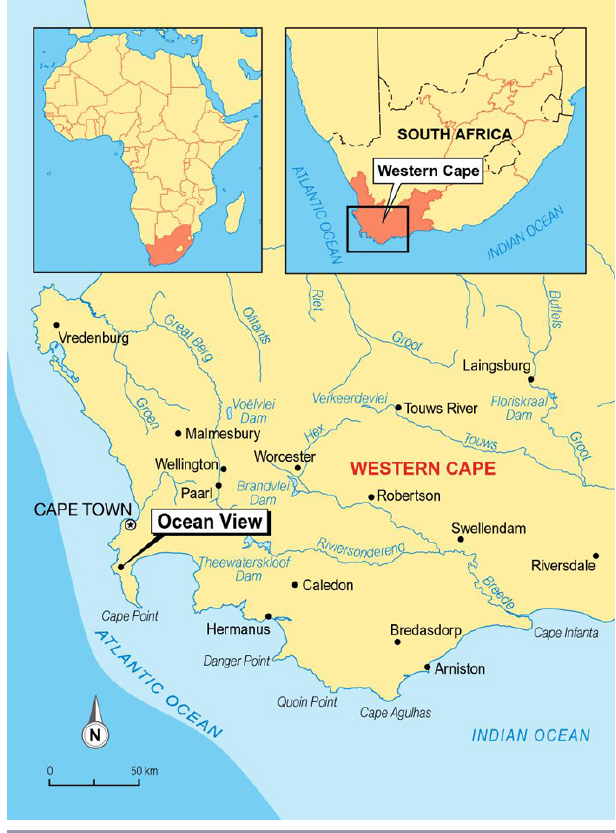
Fig. 1 . Ocean View located in the Western Cape Province of South